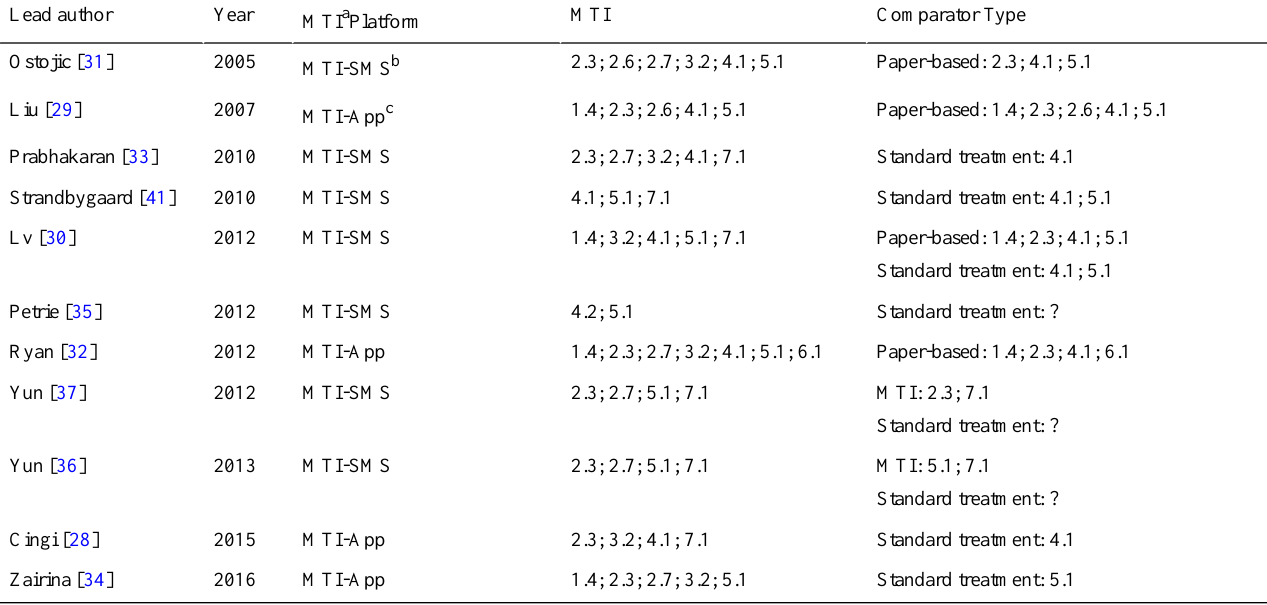
Table 2. Classification of behavior change technique taxonomy for each included